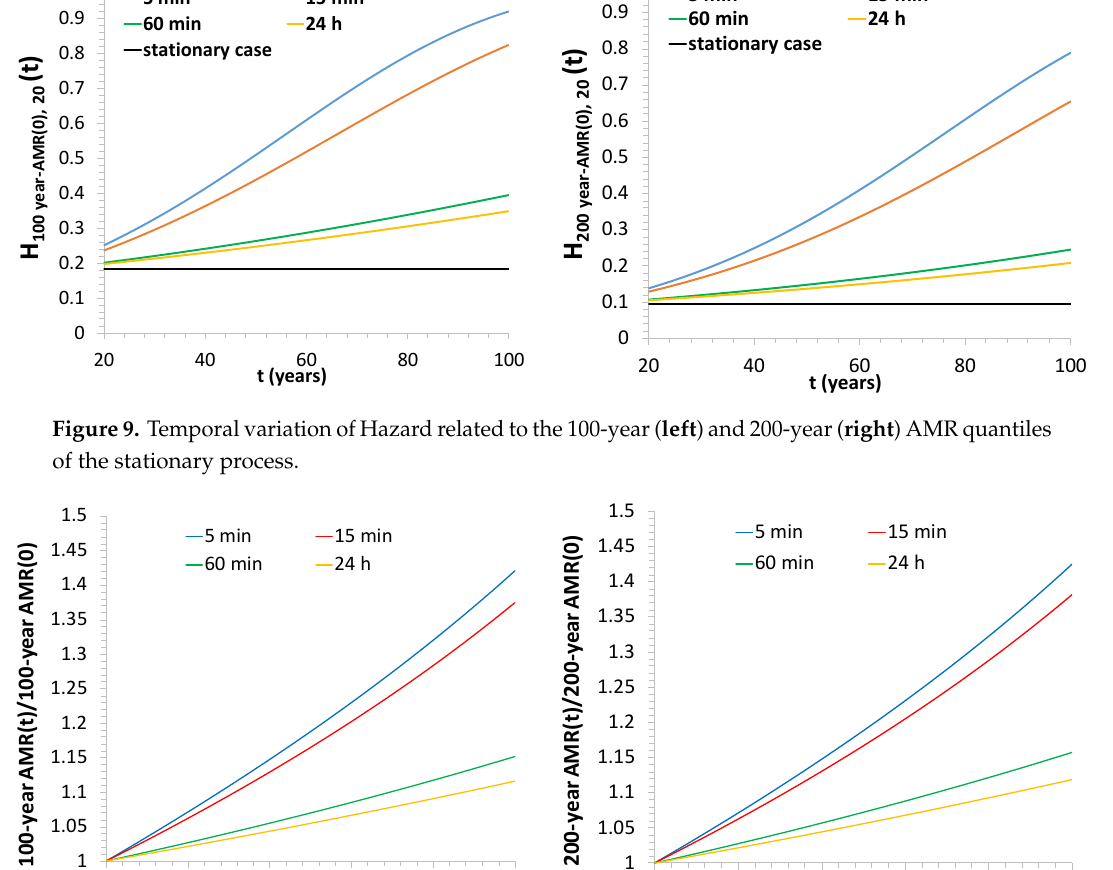
Figure 9. Temporal variation of 100-year ( left ) and 200-year ( right ) AMR quantiles with respect to the correspondent values